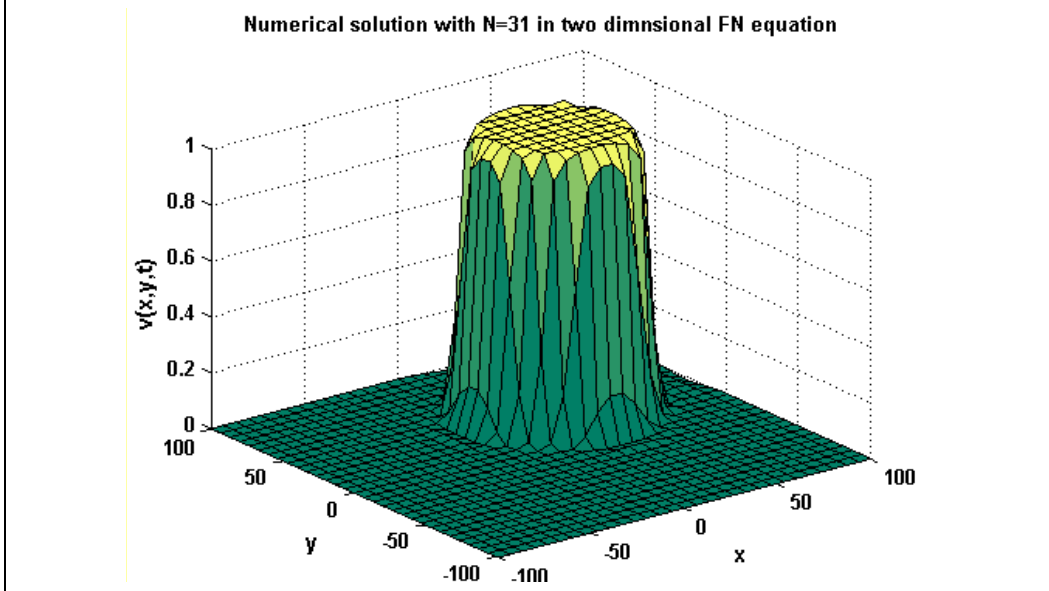
Figure 5. Numerical solution of Example 3 with N-31 and 𝜁 = 0.15 over the square